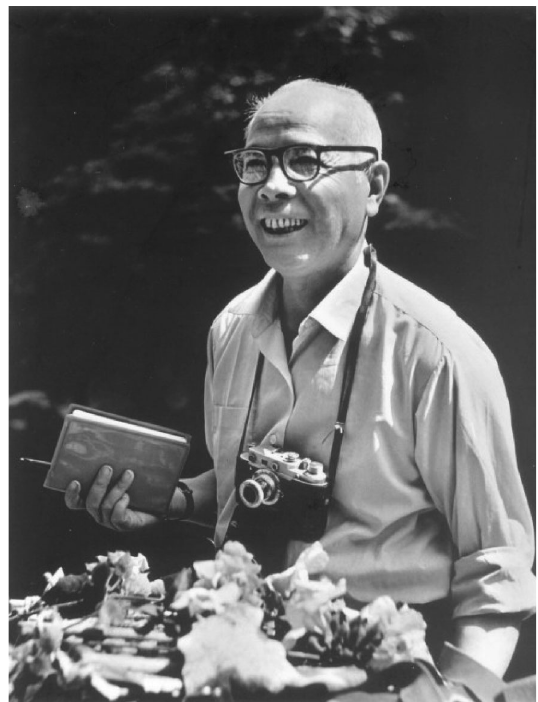
Figure 1. Mr. Xitao Cai (Hse-Tao TSAI, April 10th, 1911 – March 9th, 1981).